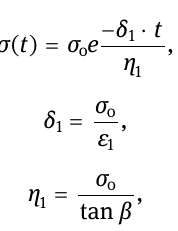
Figure 3: Creep samples inside the mold.